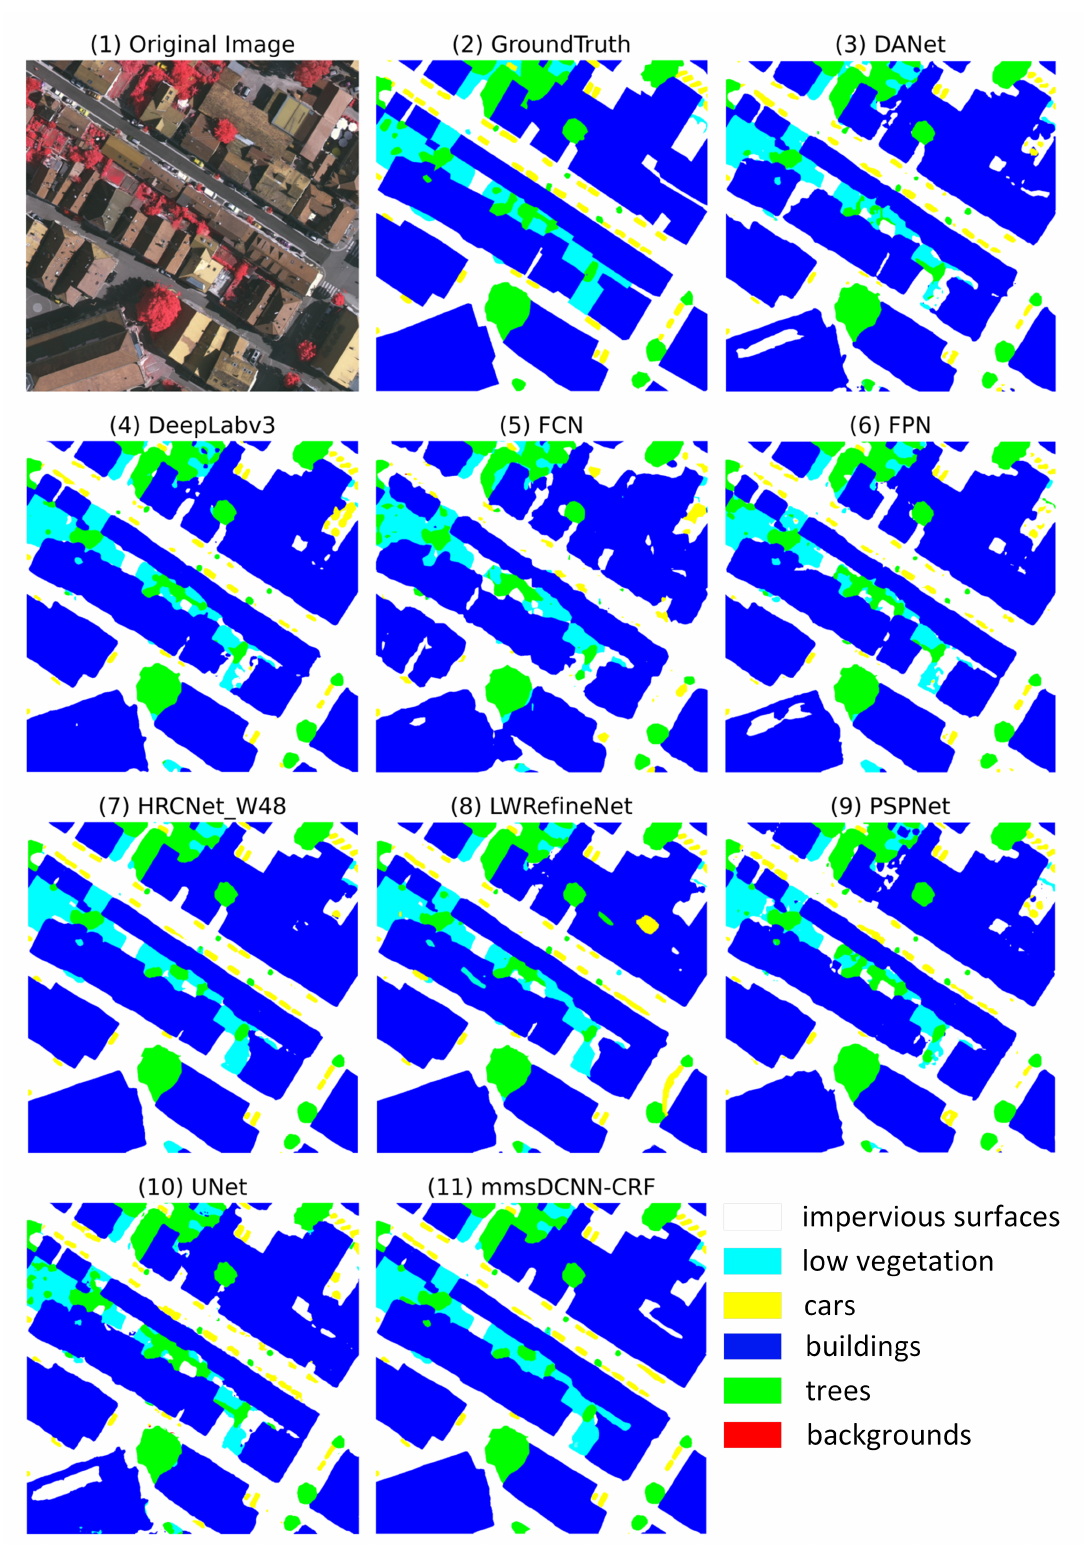
Figure 8. The figure shows the initial segmentation of the mmsDCNN and the segmentation map as estimated from